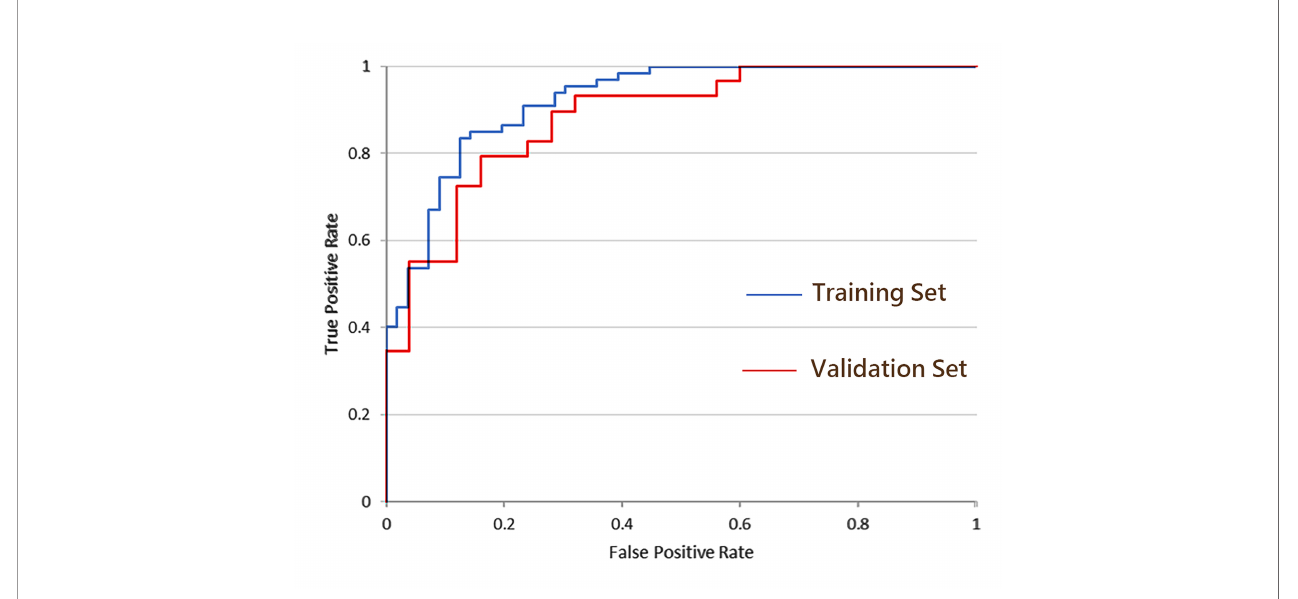
FIGURE 4 | ROC curves of the combined model incorporating CE-MRI radiomics features, tumor size, and BI-RADS classi fi